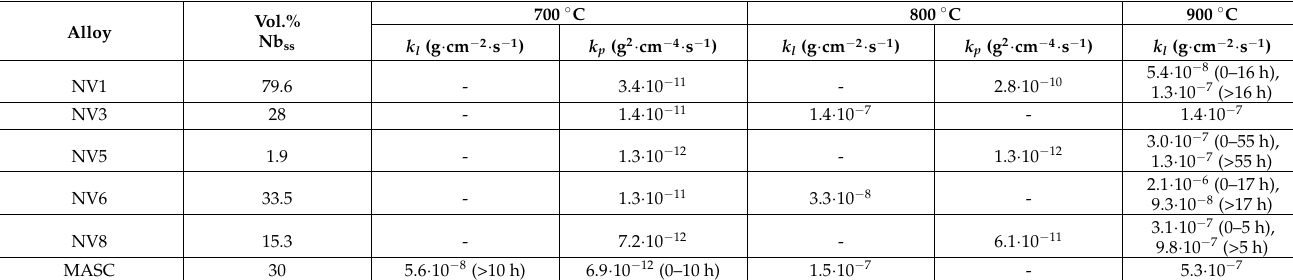
The mass change of NV1 in isothermal oxidation at 700, 800, and 900 ◦ C was compared with the “reference” MASC alloy (see the introduction) and the alloys NV3 [37], NV4 [38], NV5 [37], NV6 [39], and NV8 [38] in Figure 4. Large button/ingots of all these alloys were made using arc melting. The oxidised specimens are shown in Figure 5, and the oxidation rate constants are given in Table 4. In the latter table, the vol.% of Nb ss in the Sn-containing alloys with similar Ti concentration to the MASC alloy is also given. Note (i) that the MASC alloy was Sn-free, (ii) that the vol.% Nb ss of the alloy NV4 [38] was about 51.3%, (iii) that the alloy NV4 was very Ti-rich (45 at.%, nominal), and (iv) that the Sn content of the alloys NV3 to NV6 and NV8 was 5 at.% (nominal) compared with 2 at.% Sn in NV1 (for nominal composition of the alloys, see the Table 1 in the Appendix A). The alloy NV9 [39] suffered catastrophic pest oxidation at all three temperatures. Data for this alloy is not included in the Figure 4. Furthermore, because of (iii), data for the oxidation rate constants of the alloy NV4 is not included in the Table 4. Table 4. Oxidation rate constants of the alloys NV1, NV3, NV4, NV5, NV6, and NV8 at 700 ◦ C, 800 ◦ C, and 900 ◦ C. Alloy